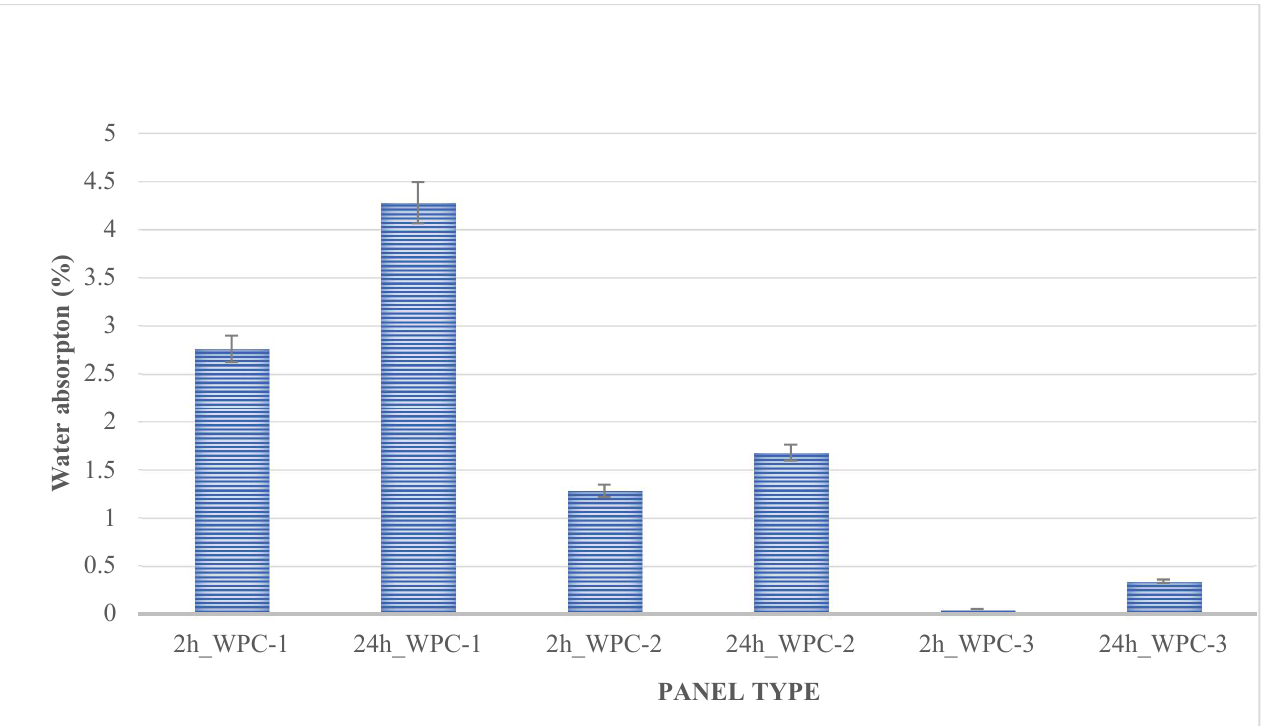
Figure 3. Water absorption of the samples.